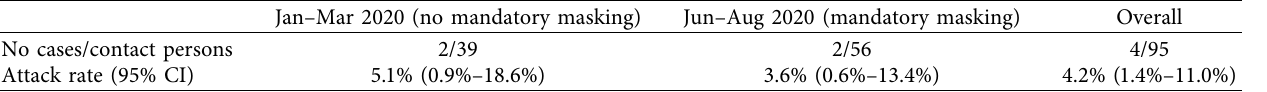
Table 3: Attack rates among close contact persons in total ( n � 95), before ( n � 39) and after ( n � 56) masking, COVID-19 flight contact tracing study, Germany, 2020.